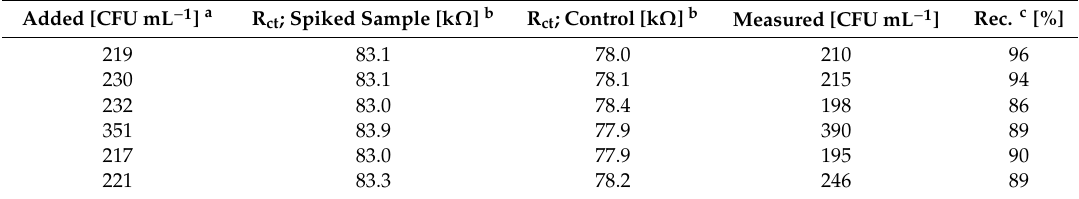
Table 1. Summary of Pt-IME flow-through analysis of hydroponic lettuce system. Listeria innocua was spiked into the system at known concentrations and pumped through a particle trap with an embedded Pt-IME biosensor. After 5 min of continuous flow, the pump was turned o ff for electrochemical impedance spectroscopy (EIS) analysis with a handheld potentiostat. Data were analyzed using an equivalent circuit model for calculating R ct